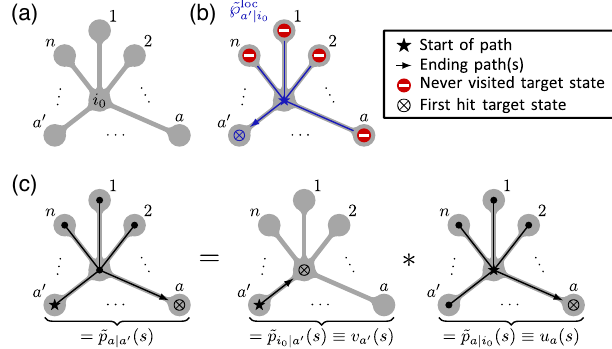
FIG. 10. Starlike graph. (a) Starlike graph with N states from which n ¼ N − 1 are “ outer states ” a; a 0 ¼ 1 ; … ; n and one state is called the “ inner state ” N . (b) Conditional first-passage paths belonging to ˜ ℘ loc ð s Þ . (c) Illustration of ˜ p a ð s Þ ¼ ˜ p a ð s Þ × j a 0 j i 0 a 0 j i 0 ˜ p s Þ , which holds for a 0 ≠ a and effectively means that each i 0 j a 0 ð path starting from a 0 must pass through the center i 0 to reach the other end a ( a ≠ a 0 ). The matrix D ð s Þ in Eq. (C4) accounts